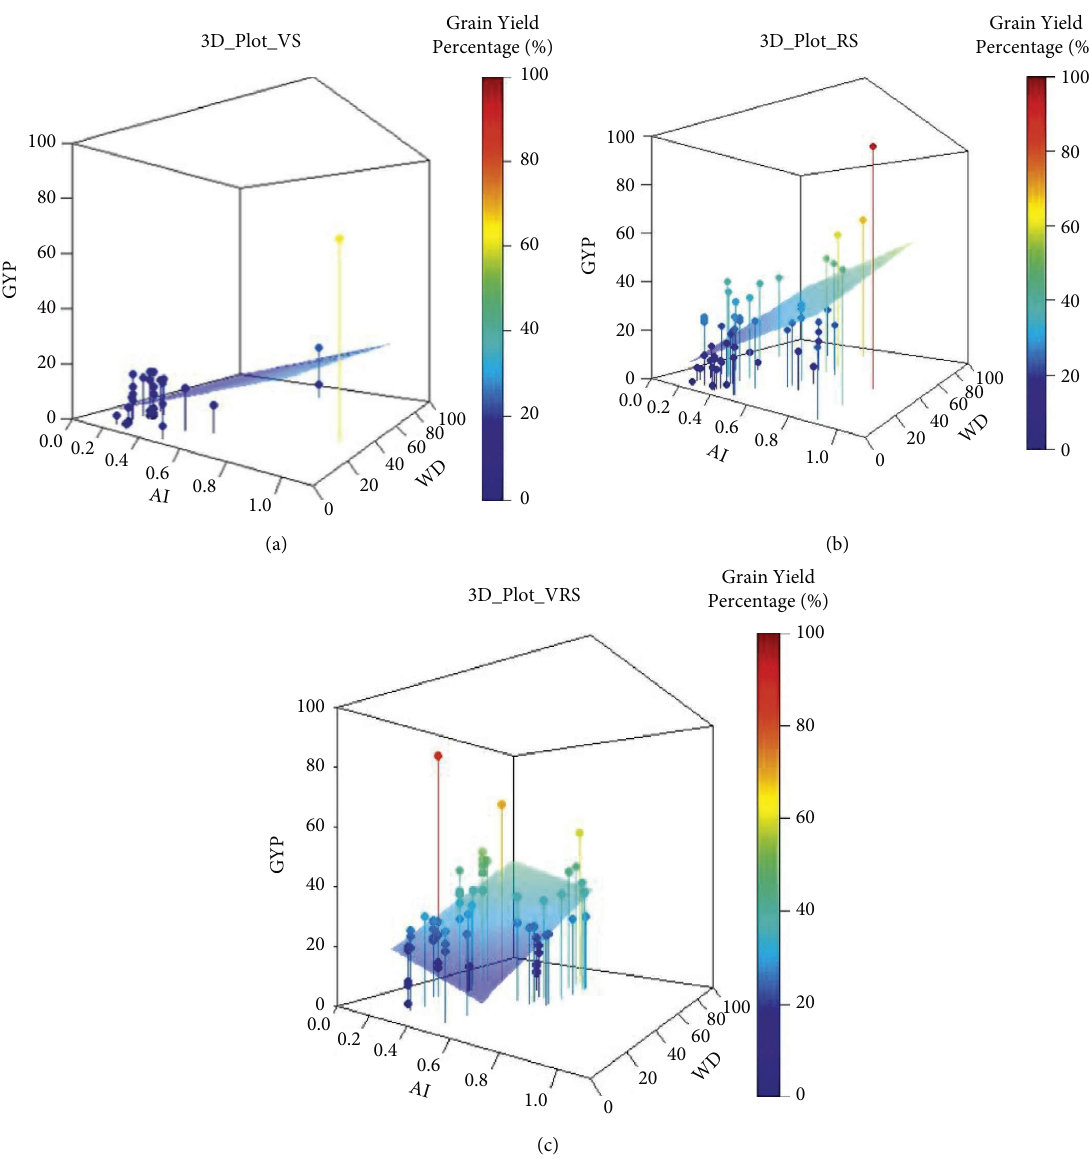
Figure 7: 3D plot of grain yield variation (grain yield percentage) in relation to water defcit level (WD) and climatic zones represented by the aridity index (AI) at (a) vegetative stage, (b) reproductive stage, and (c) vegetative and reproductive